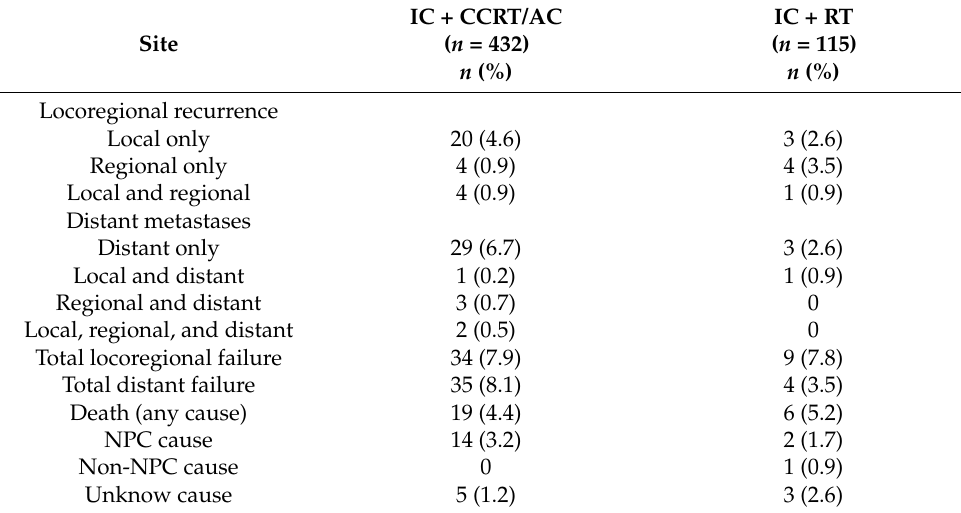
Table 2. Patterns of treatment